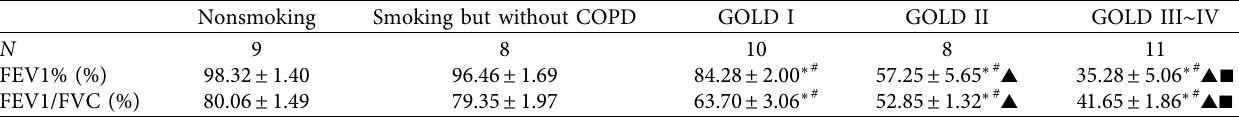
Table 2: Measurement results of lung function in different groups.